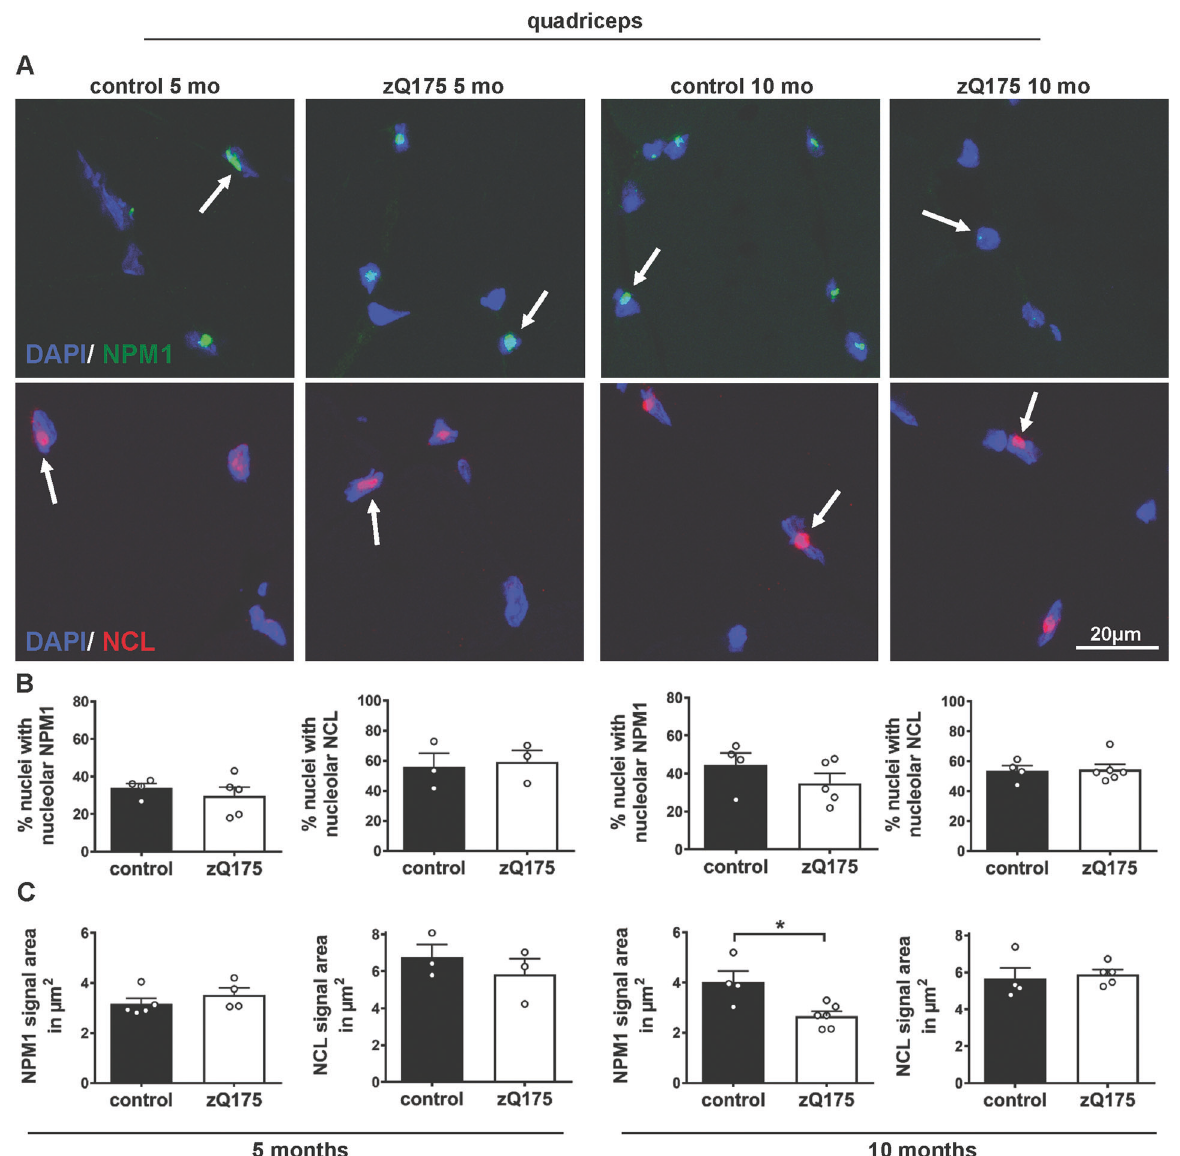
Fig. 5 NPM1 nucleolar localization is altered in the skeletal muscle (quadriceps) of zQ175 mice at a symptomatic stage. A Representative confocal images of quadriceps cryosections stained for NPM1 (green) or NCL (red) in control and zQ175 mice at 5 and 10 months. Nuclei are labeled with DAPI (blue). The arrows point out to NPM1 or NCL signal. Scale bar: 20 μ m. B Quanti fi cation of the percentage of nuclei with nucleolar localization of NPM1 or NCL at 5 and 10 months (mo) in control (N, number of mice, NPM: 4, 4; NCL: 3, 4) and zQ175 (N: number of mice, NPM: 5, 5; NCL: 3, 6) mice shows no signi fi cant differences. C Quanti fi cation of the mean area of the NPM1 or NCL signal (in μ m 2 ) per DAPI positive nuclei at 5 and 10 months (mo) in control (N for NPM1: 5, 4; for NCL: 3, 4) and zQ175 (N for NPM1: 4, 6; for NCL: 3, 5) mice shows a signi fi cant reduction in nucleolar NPM1 signal at 10 months by Mann – Whitney U test ( p = 0.038). Error bars represent SEM. * p <